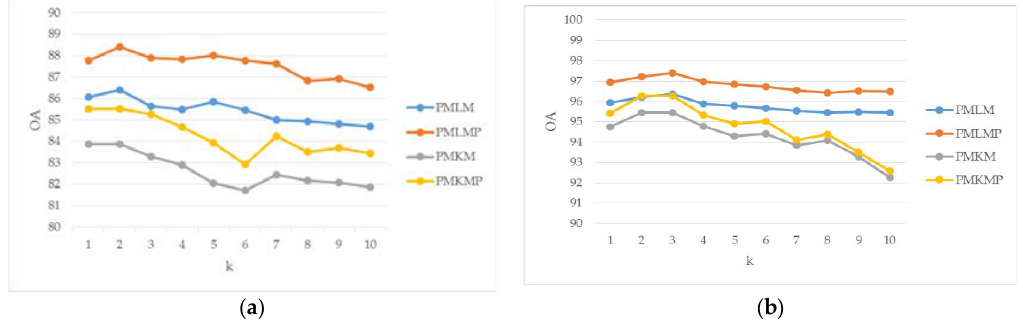
Figure 5. The relation between the classification result and parameter k. ( a ) Indian Pines; ( b ) Salinas.